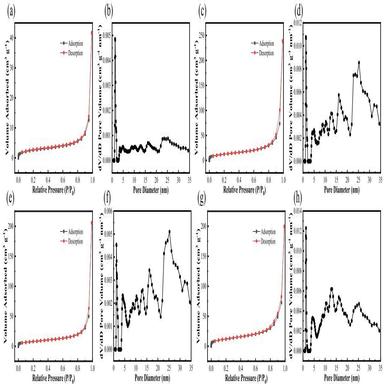
Nitrogen adsorption/desorption isotherm and pore-size distribution of (a-b) Cu-IM, (c-d) Co-MOF, (e-f) Cu-IM/Co-MOF, (g-h) Cu-IM/Co-MOF 250.